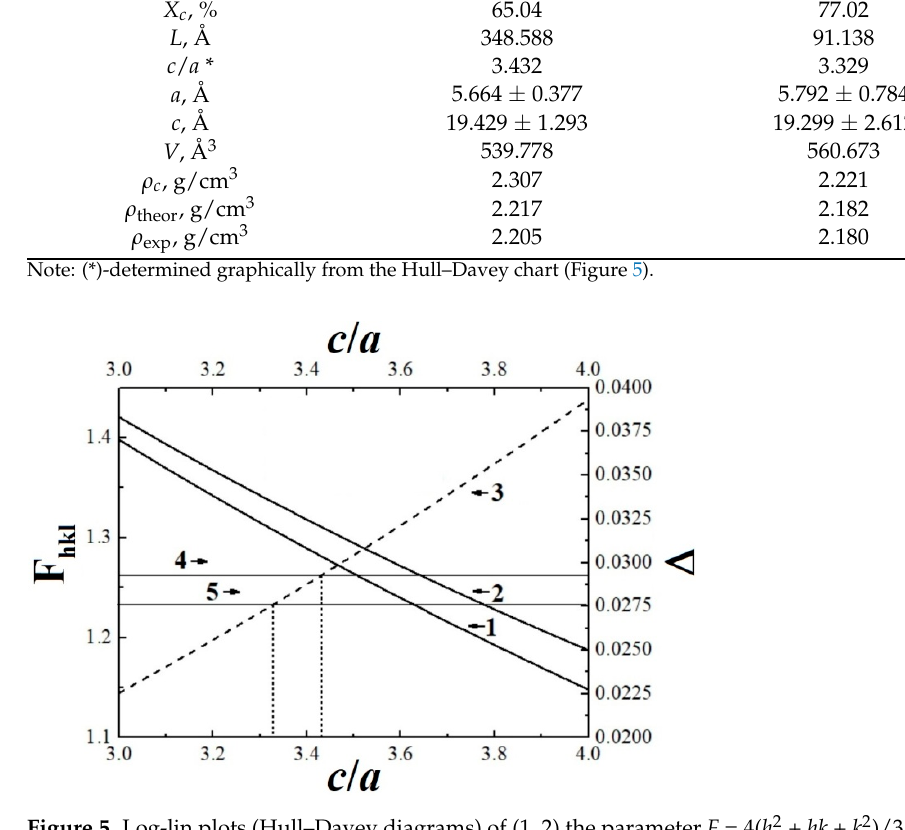
Figure 5. Log-lin plots (Hull–Davey diagrams) of (1, 2) the parameter F = 4( h 2 + hk + k 2 )/3 + l 2 /( c/a ) 2 for reflections hkl = (1) 0015 and (2) 1015 in the X-ray spectrum of polytetrafluoroethylene, (3) the difference F 1015 –F 0015 , and (4, 5) Δ = 2log (d 0015 ) − 2log (d 1015 ) for the (4) initial and (5) thermal-radiation- modified polytetrafluoroethylene samples versus the ratio of the hexagonal lattice constants c/a . Here, d 0015 and d 1015 are the interplanar spacings for reflections hkl = 0015 and 1015, respectively. The left and lower axes refer to plots 1–3, whereas the right and upper axes refer to plots 4 and 5. The vertical dashed lines mark the points of intersection of straight lines 4 and 5 with dependence 3.